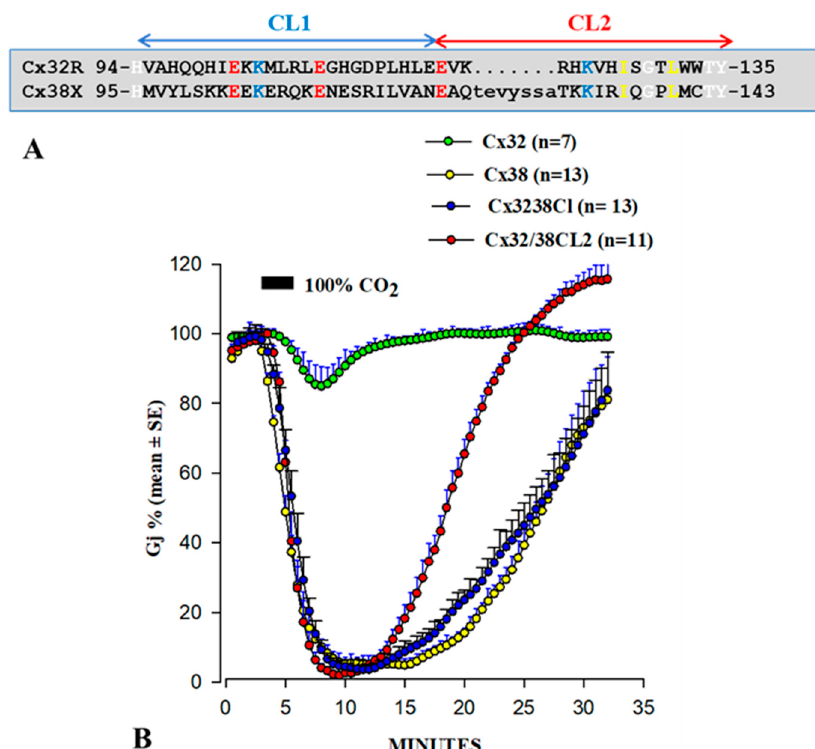
Figure 6. Sequences of the cytoplasmic loop (CL) of rat Cx32 and Xenopus Cx38 ( A ). Gj changes induced by 100% CO 2 , monitored in oocytes expressing Cx32, Cx38, or Cx32/38 chimeras are shown in B. Channels made of Cx32/38CL (Cx32 ′ s CL being replaced by that of Cx38) or Cx32/38CL2 (Cx32 ′ s CL2 being replaced by that of Cx38) reproduce precisely the gating efficiency of Cx38 channels in both magnitude and rate ( B ), but Gj recovers faster in Cx32/38CL2 channels. Note that CL2 contains a CaM-binding site (see Figure 5A,B). Adapted from [65,66].